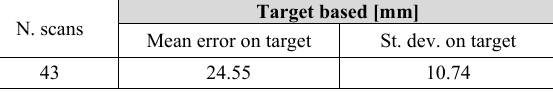
Table 6. Target based accuracy results